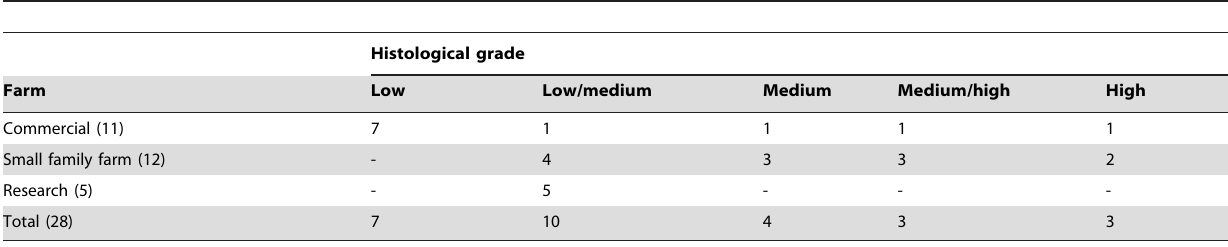
Table 5. Average intestinal histological grade for Blastocystis positive porcine large intestinal sections in each piggery setting.